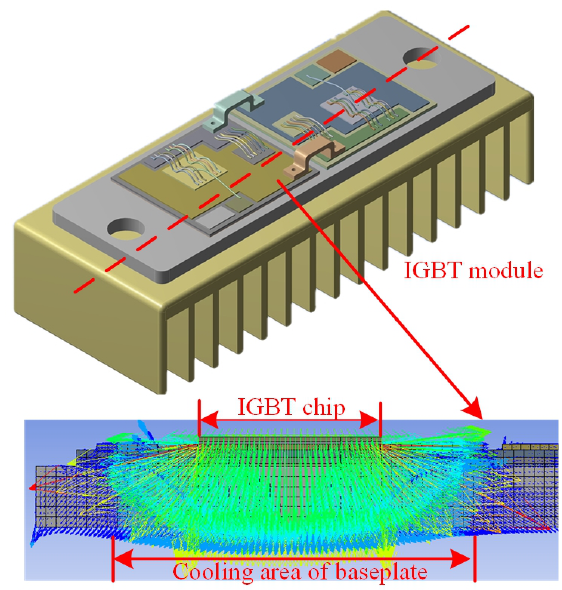
Figure 2. The heat flux in a healthy IGBT module